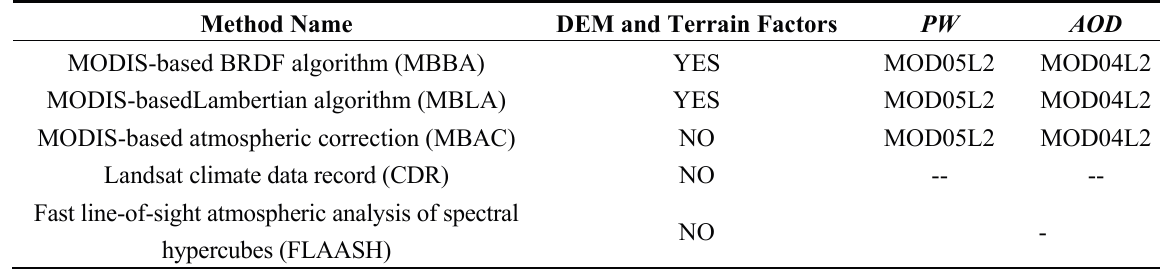
Table 1. Basic descriptions of the four atmospheric and topographic normalization